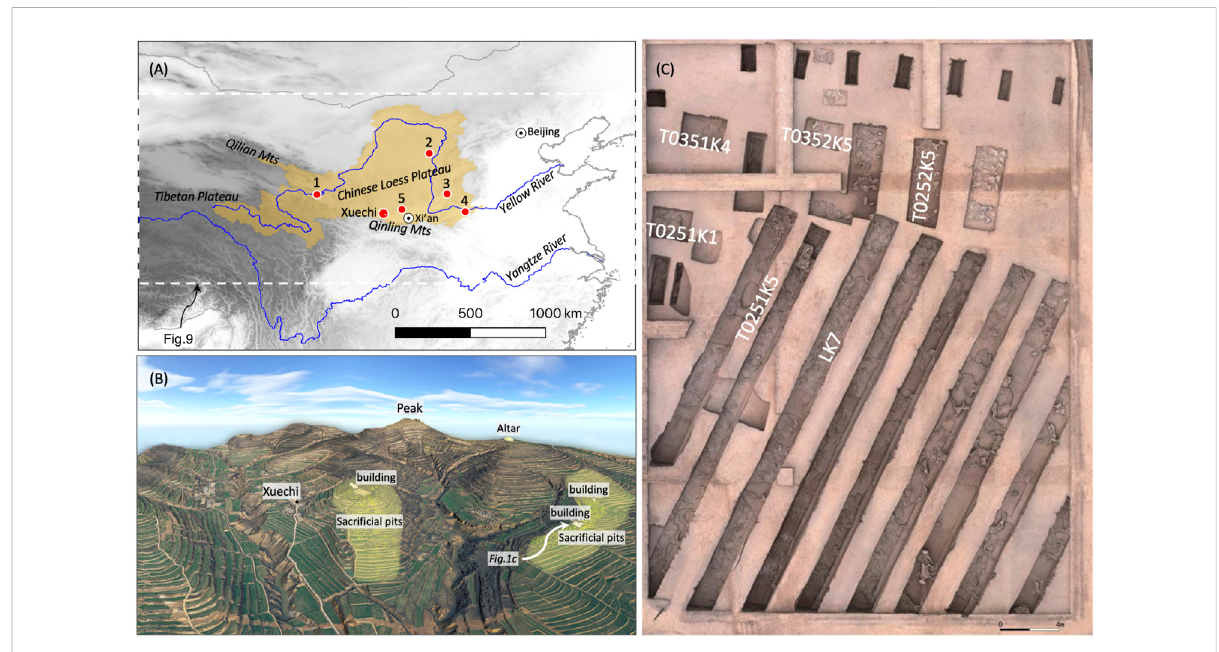
The context of Xuechi Site. (A) Location of the Xuechi site, and comparable sites mentioned in text. 1 Lajia; 2 Shimao; 3 Taosi; 4 Er ’ litou; 5 Zaoshugounao; (B) Landscape of the Xuechi site. The yellow shading areas indicate the sacri fi cial pits con fi rmed by extensive drillings; (C) The excavation square with the sampled sacri fi cial pits